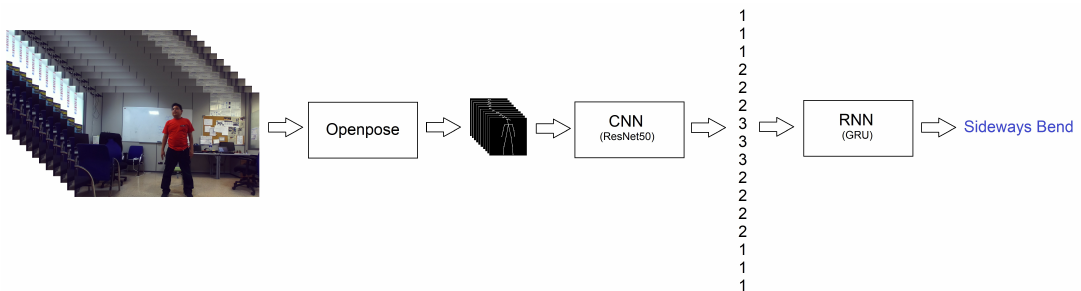
Figure 4. C2R architecture, which combines a CNN based on ResNet50 [31] with a RNN composed of GRU, to properly recognise the physical exercise